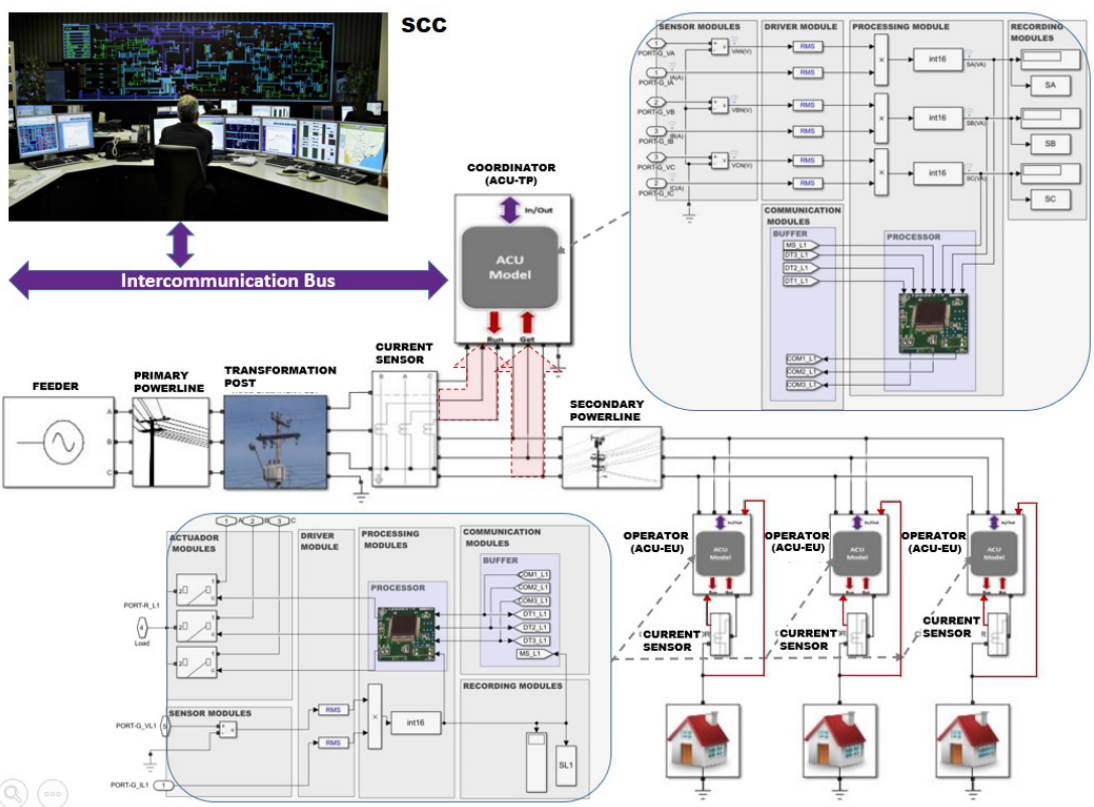
Figure 10. Test circuit implemented with SIMULINK.